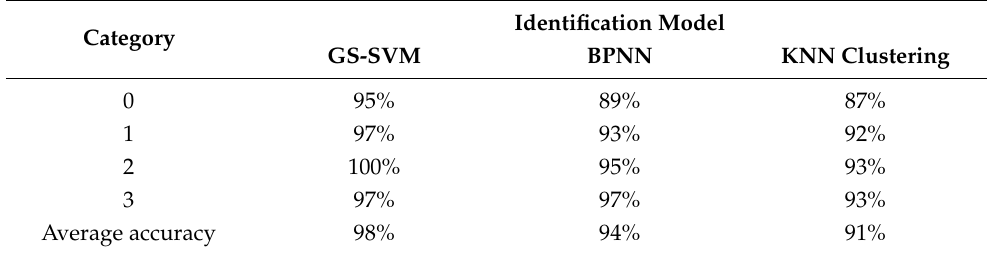
Table 5. Identification effect comparison of different